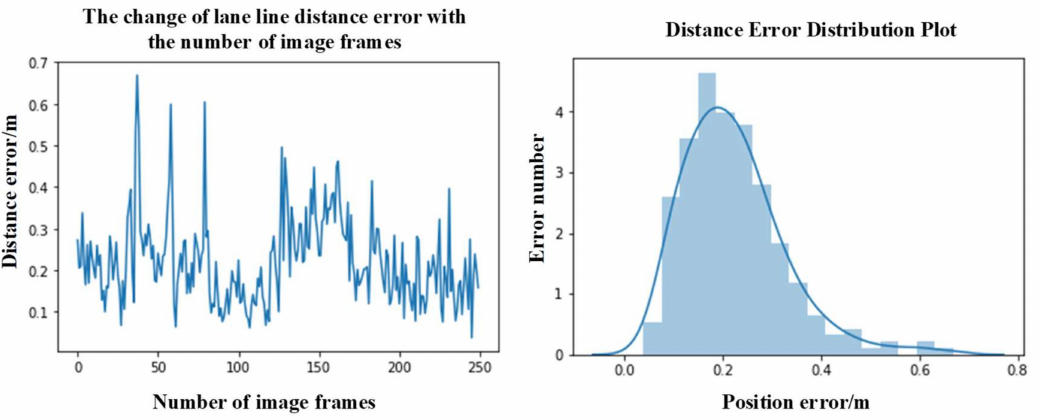
Figure 8. Distance D positioning error. ( left ): the change of error with the number of frames; ( right ): the distribution of distance